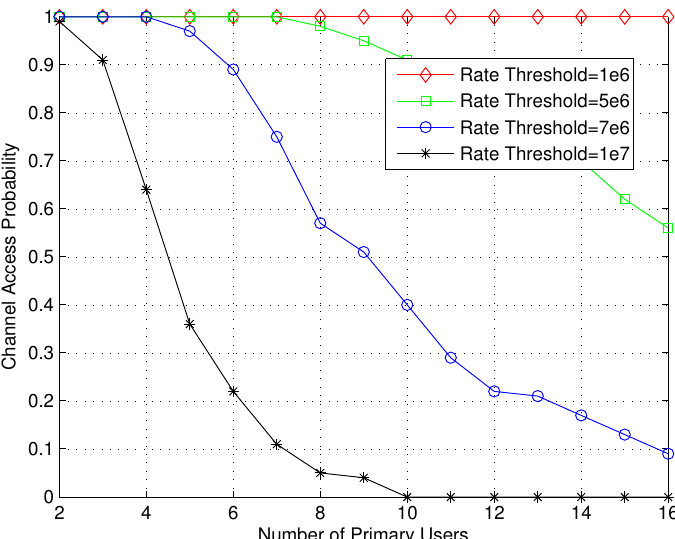
Figure 7. The effect of number of primary users on channel access probability for different rate